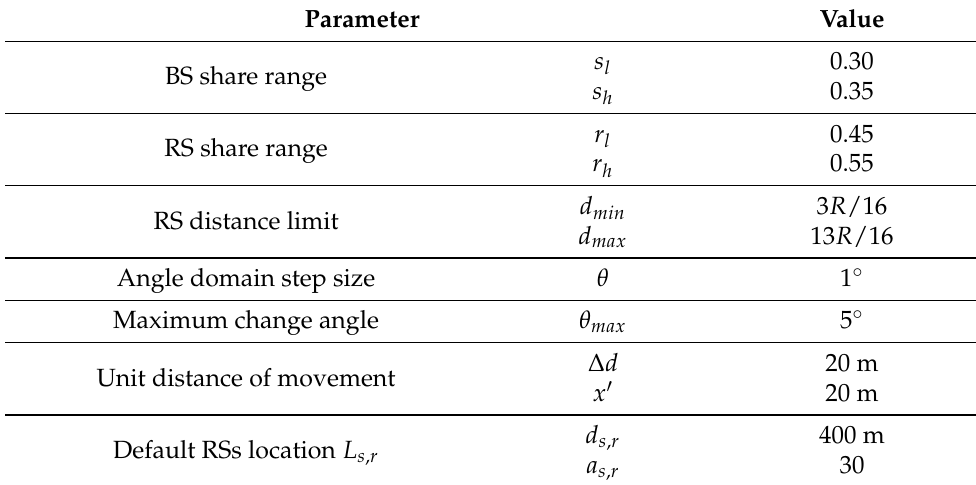
Figure 5. Spectral efficiencies with different step size x (cid:48) . Table 3. Proposed algorithm input